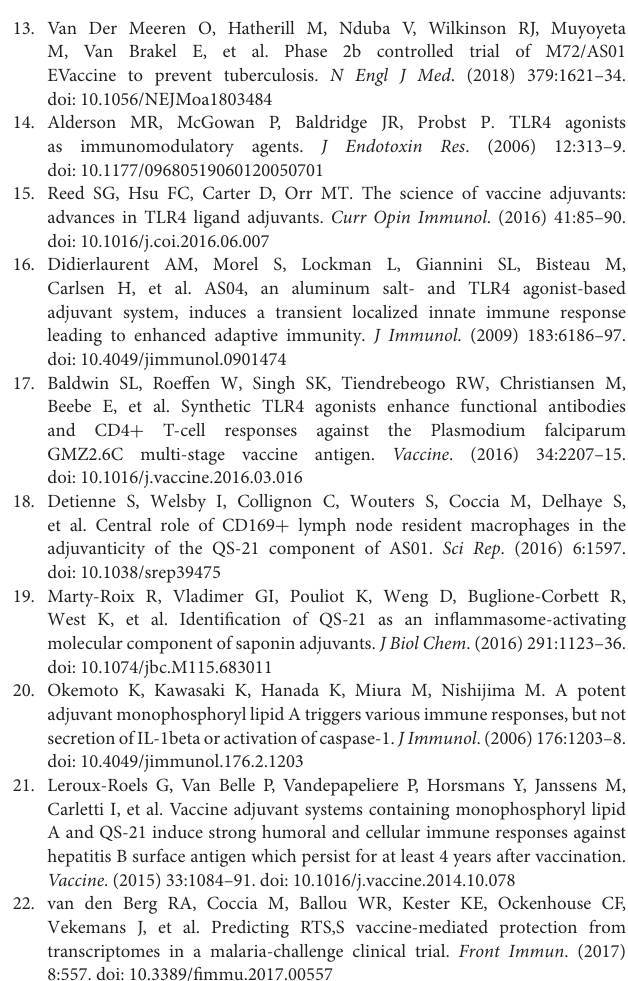
Figure S1 | The CellDesigner Model captures the following key compartments: the muscle injection site (A) , the lymphatic vessels (B) , the draining lymph node (dLN) [including paracortex (C) , B cell follicles (D) , germinal center (E) ], the blood (F) , and the bone marrow (G) . This model captures high-level mechanisms that are hypothesized to give rise to the phenomena observed by experimentation in mice. This begins with the intramuscular injection (34) of the vaccine at time zero (A) and captures the events leading to the secretion and circulation of antibodies (E,F) , and lymph node egression of effector memory T cells (9). Datasheet 1 | Full list of Domain Model Diagrams: the full list of diagrams that were created for the AS01 MoA Domain Model. Datasheet 2 | A list of the entire Core AS01 MoA Domain Model